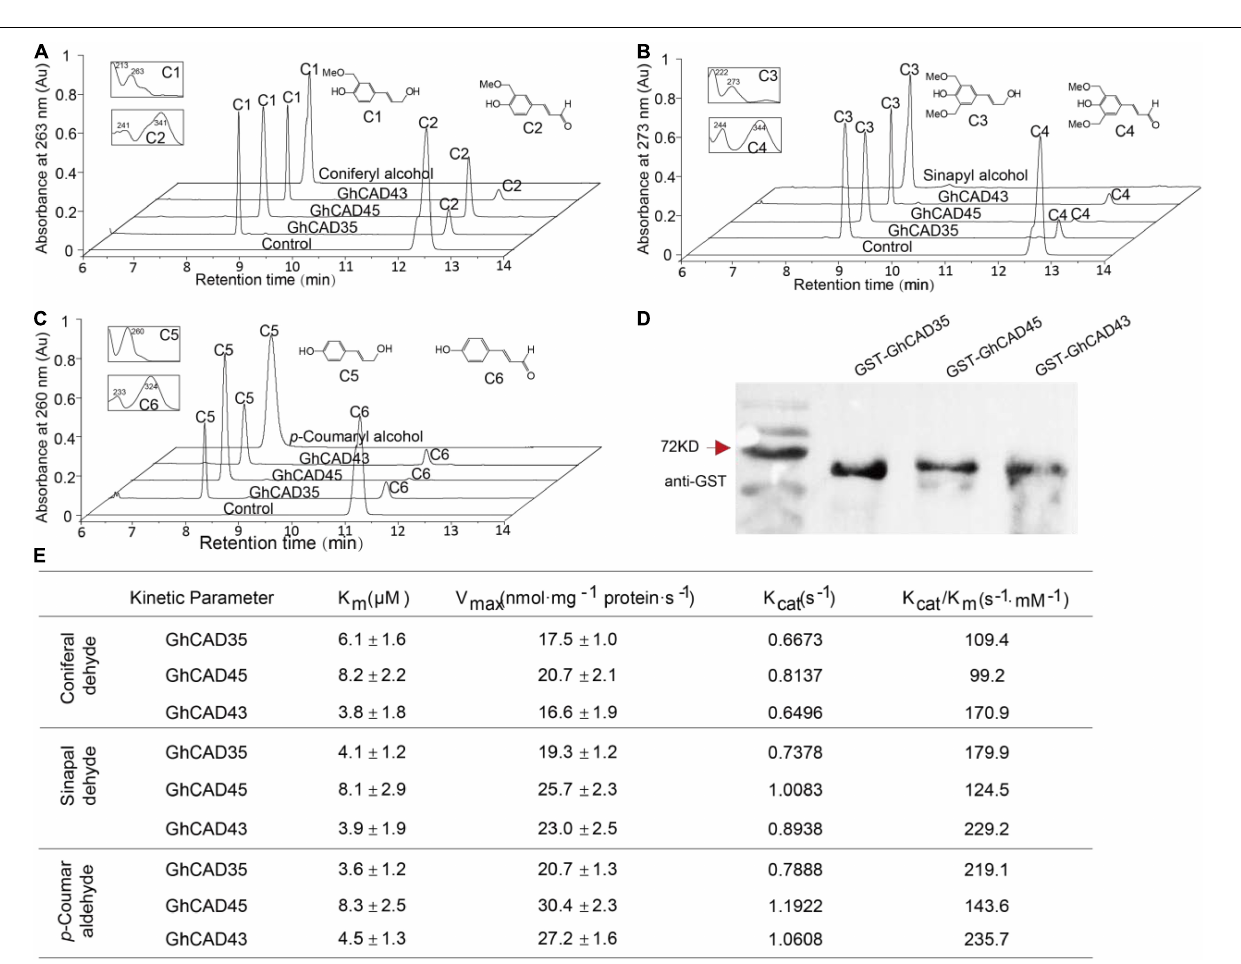
FIGURE 4 | Characterization of the cinnamyl alcohol dehydrogenase (CAD) catalytic activities of GhCAD35, GhCAD45, and GhCAD43. (A–C) HPLC analyses of in vitro incubation of GhCAD35, GhCAD45, and GhCAD43 with coniferaldehyde, sinapaldehyde and p -coumaraldehyde, to yield corresponding monolignols, coniferyl alcohol, sinapyl alcohol, and p -coumaryl alcohol, respectively. C1-C6 indicate coniferyl alcohol, coniferaldehyde, sinapyl alcohol, sinapaldehyde, p -coumaryl alcohol, and p -coumaraldehyde, respectively. Controls in A-C were incubated with GST protein. (D) Western blot showing the levels of recombinant GhCAD35, GhCAD45, or GhCAD43 protein fused with a GST tag. GST antibody was used. (E) The catalytic parameters of GhCAD35, GhCAD45, and GhCAD43 toward the substrates p -coumaraldehyde, coniferaldehyde, and sinapaldehyde,